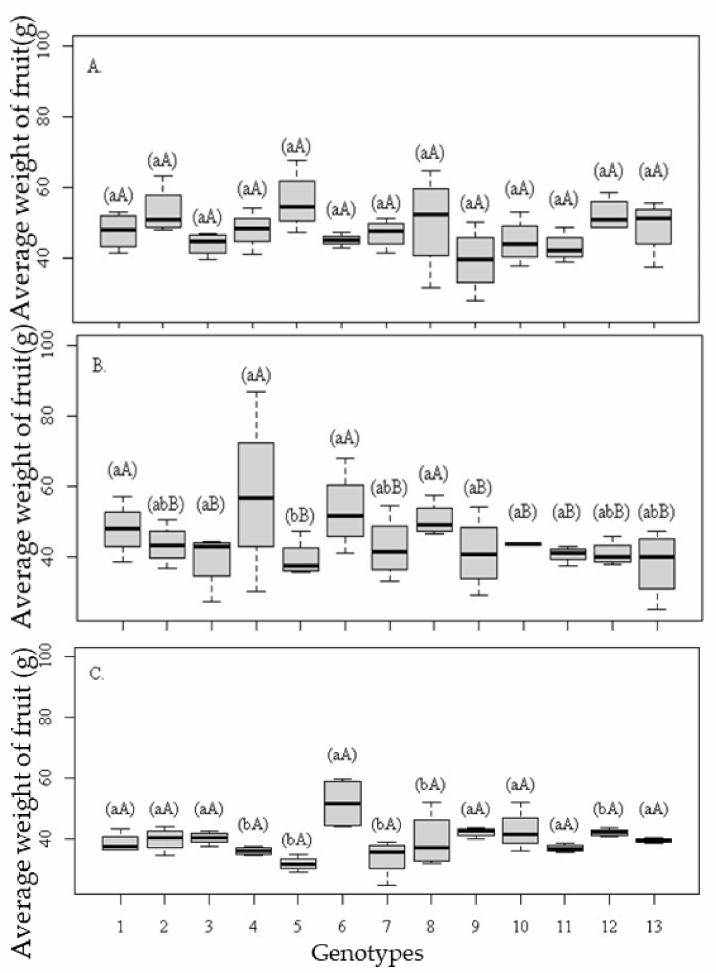
Figure 6. Boxplot relative to the average weight of fruit of 13 citrus rootstocks in combination with ‘Tahiti’ acid lime ( Citrus × latifolia (Yu. Tanaka) Tanaka) under irrigation with waters of 0.14 ( A ), 2.40 ( B ), and 4.80 dS m − 1 ( C ), in the second year. For identification of genotypes, see Table 1. Boxplots with the same lowercase letter do not differ statistically, according to the Tukey test between salinity levels ( p ≤ 0.05), and those with the same uppercase letter belong to the same genotype group, according to the Scott–Knott test ( p ≤